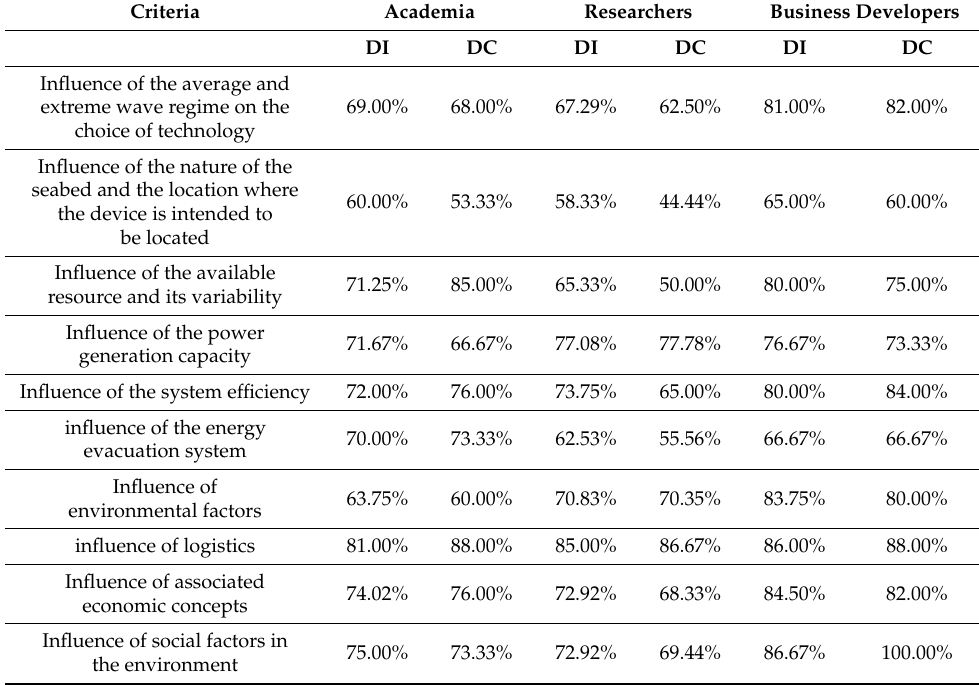
Table 7. Degree of importance (DI) and degree of consensus (DC) for every expert